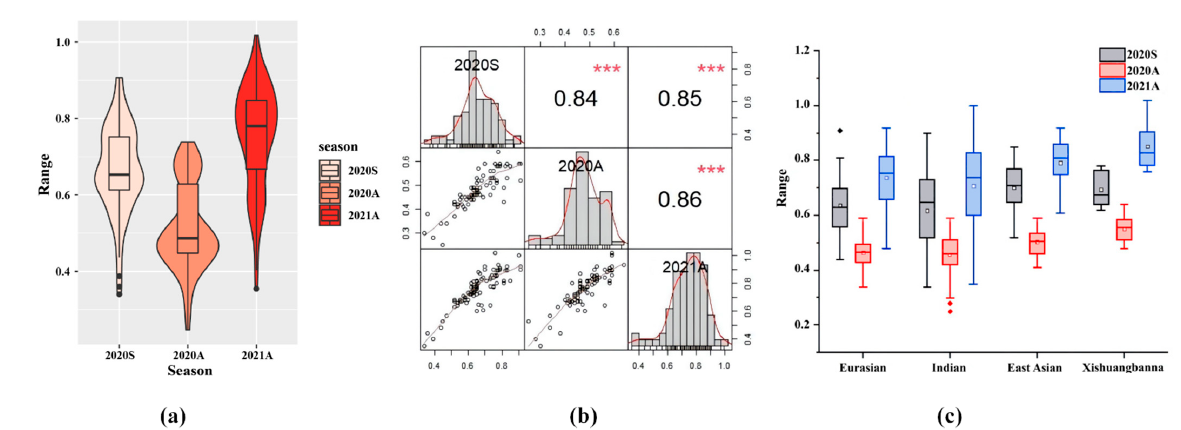
Figure 1. Phenotypic analysis of cucumber stem diameter in three seasons. ( a ) Violin and box plots depicting phenotypic distribution of cucumber stem diameter in 2020S, 2020A, and 2021A. ( b ) Frequency distribution and Spearman rank correlations of the mean values of the CG lines in 2020S, 2020A, and 2021A. *** indicates significance p < 0.01. ( c ) Phenotypic distribution of cucumber stem diameter in four ecotypes of the CG lines in 2020S, 2020A, and 2021A. ◆ indicate significance outliers. 3.2. Clustering Analysis of Stem Diameter in Core Germplasms According to the phenotypic data of cucumber stems in the three seasons, these CG lines could be grouped into four clusters—: Ⅰ , Thin; Ⅲ , Intermediate thin; Ⅳ , Intermediate thick; Ⅱ , Thick (Table S4; Figure 2). Each cluster contains different ecotypes. The thin stem group contained the Indian and Eurasian types. The intermediate thin stem group con ‐ tained the East Asian type, the Eurasian type and the Indian type. The thick stem group and intermediate thick stem group contained four ecotypes, most of which were the East Asian type. Here, the CG lines with the stem diameter falling within the top 20% in all three seasons were considered thick stem materials, while those within the top 20% in all three seasons were considered thin stem materials. Finally, 15 thick stem lines and 13 thin stem lines were selected and used for further analysis (Table S5).